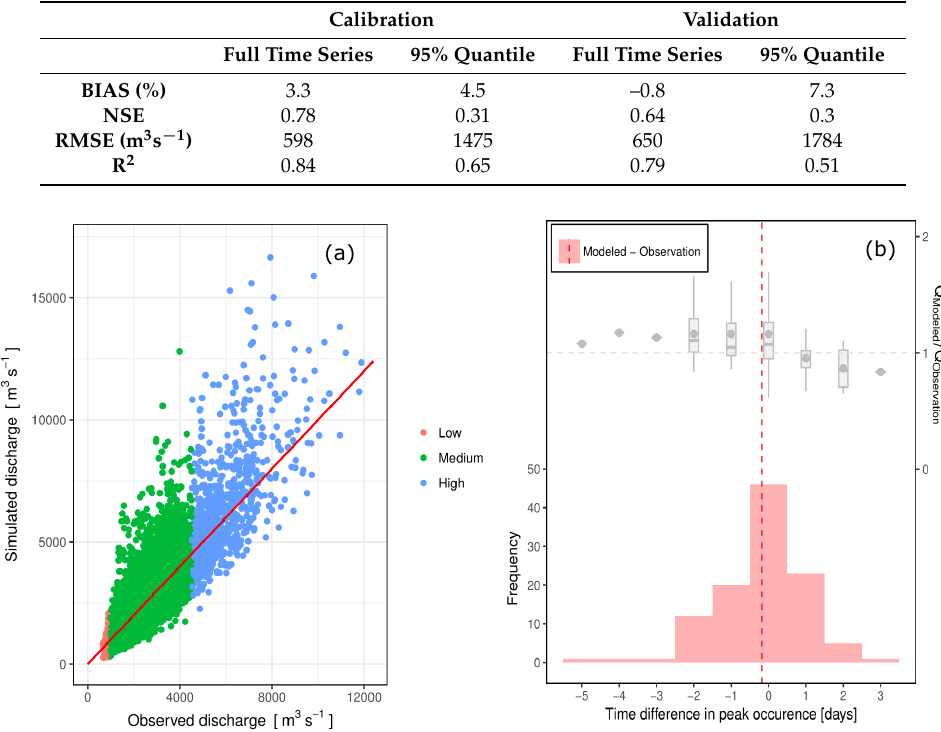
1. Performance index for the coupled Spatial Processes in Hydrology